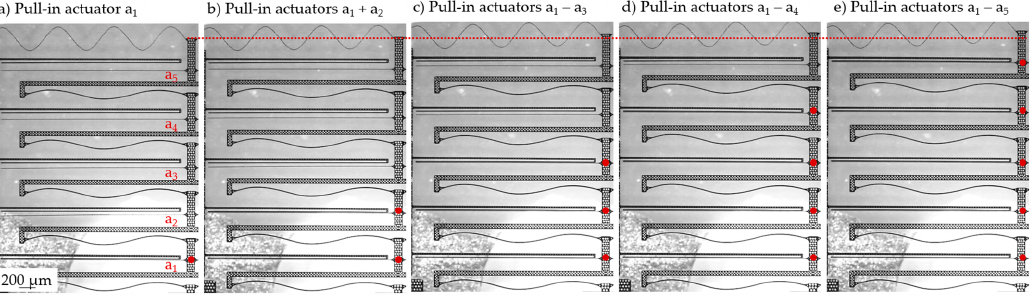
Figure 10. Displacement of the stepwise actuator; the voltage is applied to ( a ) actuator a 1 , ( b ) actua- tor a 1 and a 2 , ( c ) actuators a 1 to a 3 , ( d ) actuators a 1 to a 4 , ( e ) all actuators.